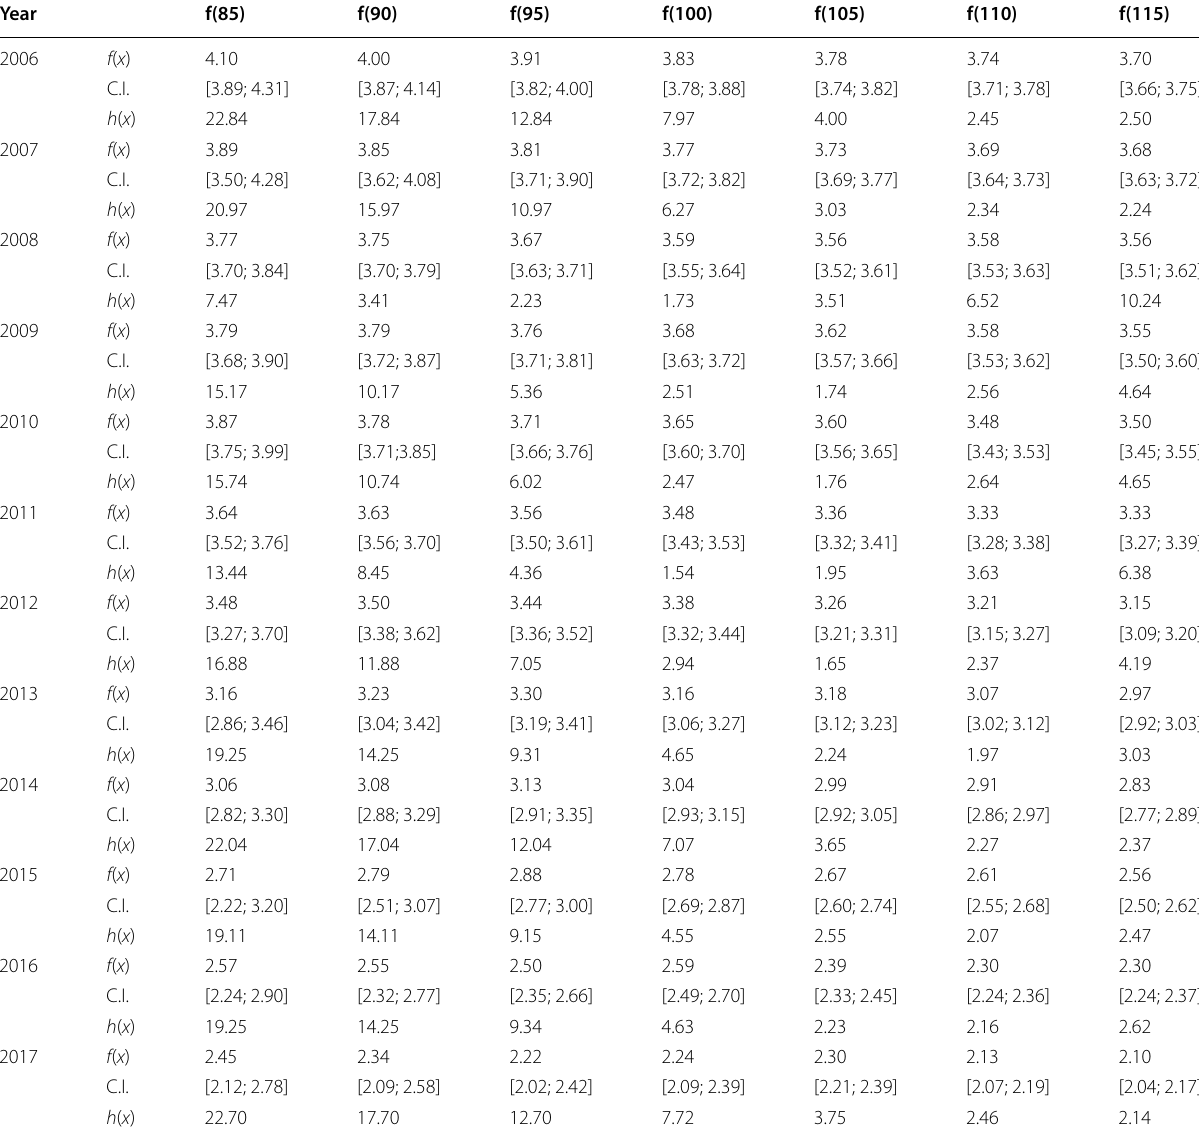
Table 3 Local linear regression: Technical Discount Rate Related to the Funding Ratio